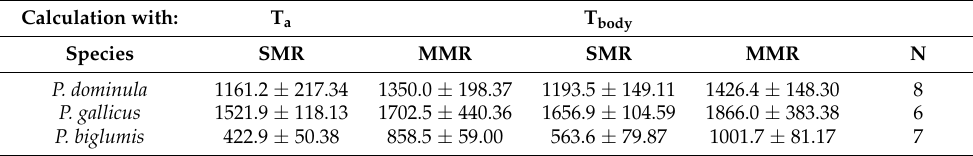
Table 1. Mass specific (summed) energetic expenditure (J g − 1 ) of paper wasps of a breeding season (May–October), for resting wasps (SMR, standard metabolic rate) and mixed activity (MMR, mean of active and standard metabolic rate). Calculations with ambient air nest temperature (T a ) and the wasps’ body temperature (T body ) represent means and SD. Calculations with T body consider the mean effect of T a and Radiation on T body according to Stabentheiner et al. [4]. N = number of nests. Calculation with: T a T body Species SMR MMR SMR MMR N 1161.2 ± 217.34